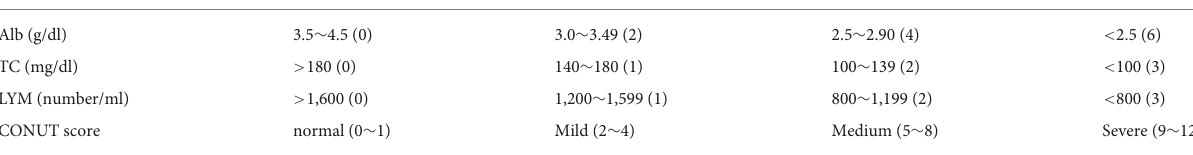
TABLE 1 The controlling nutritional status (CONUT) scoring criteria.